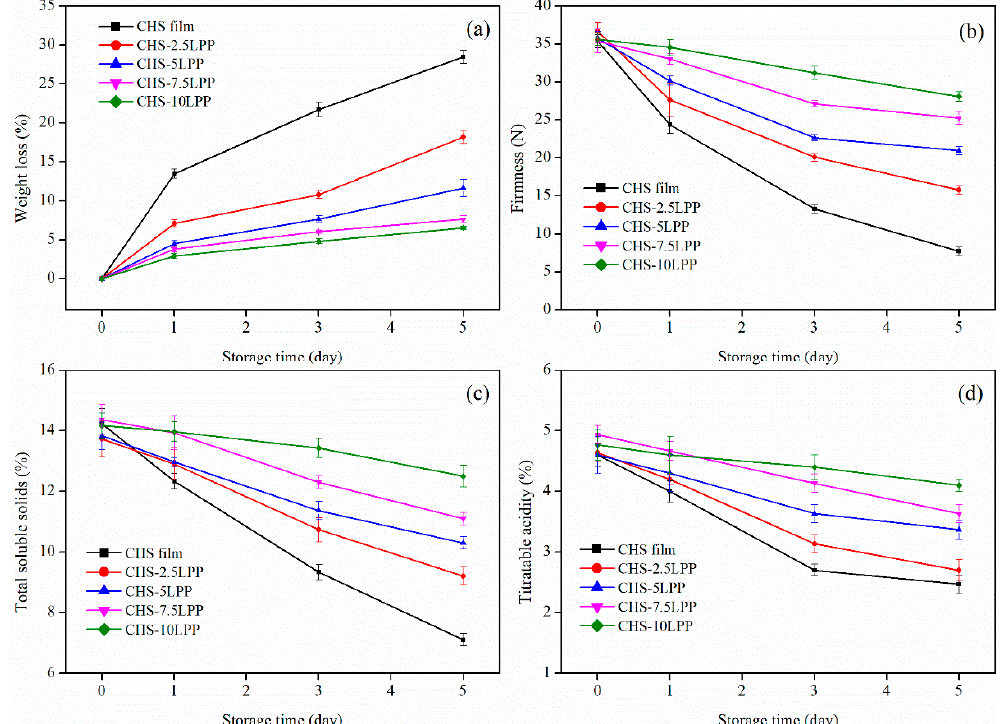
Figure 8. The weight loss ( a ), firmness ( b ), total soluble solids ( c ), and titratable acidity ( d ), of fresh-cut apple packaged in different films during storage. Fruit packaged with different films were stored at 25 °C for 0, 1, 2, 3, 4, and 5 days.